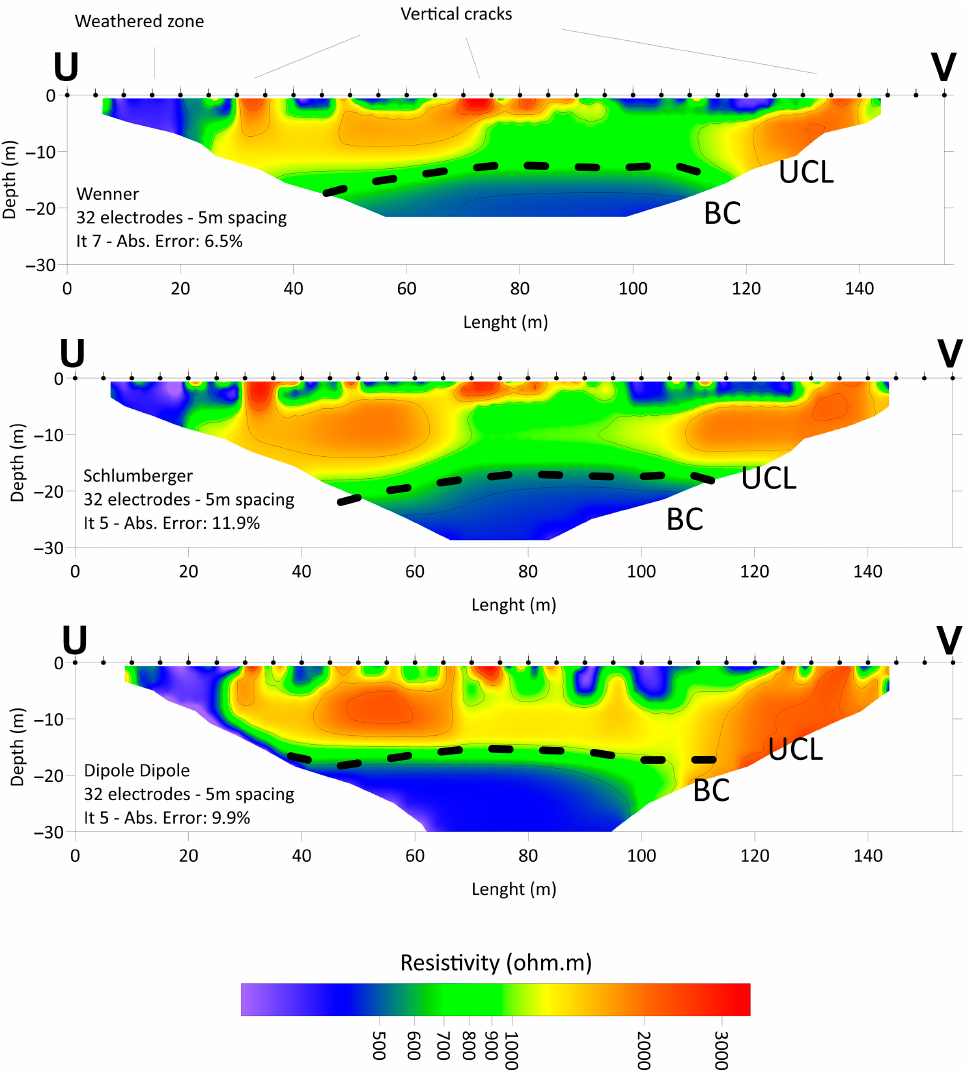
Figure 6. ERT array on the plateau of Selmun promontory (Malta). The GPR surveyed area on top of the Selmun’s plateau was characterized by a to- pographic difference in altitude of about 20 m from northwest to southeast, which was corrected with GNSS data. All profiles were interpreted in order to identify potential anomalies associated with the presence of vertical discontinuities. The results of the four GPR profiles show different anomalies due to the cracks in the UCL. The four georadar profiles were overlaid on the DEM in the GIS project, in which the vertical fractures hy- pothesised by the interpretation of the georadar anomalies were traced (Figure 7). Some inconsistencies were noted along the edges of the cliff of the Selmun promontory and the detected GPR anomalies corresponded to the visible fractures on the surface that were mapped by the UAV-generated orthomosaic. The maximum depth reached by the electro- magnetic waves was about 20 m and corresponded to the stratigraphic contact between UCL and